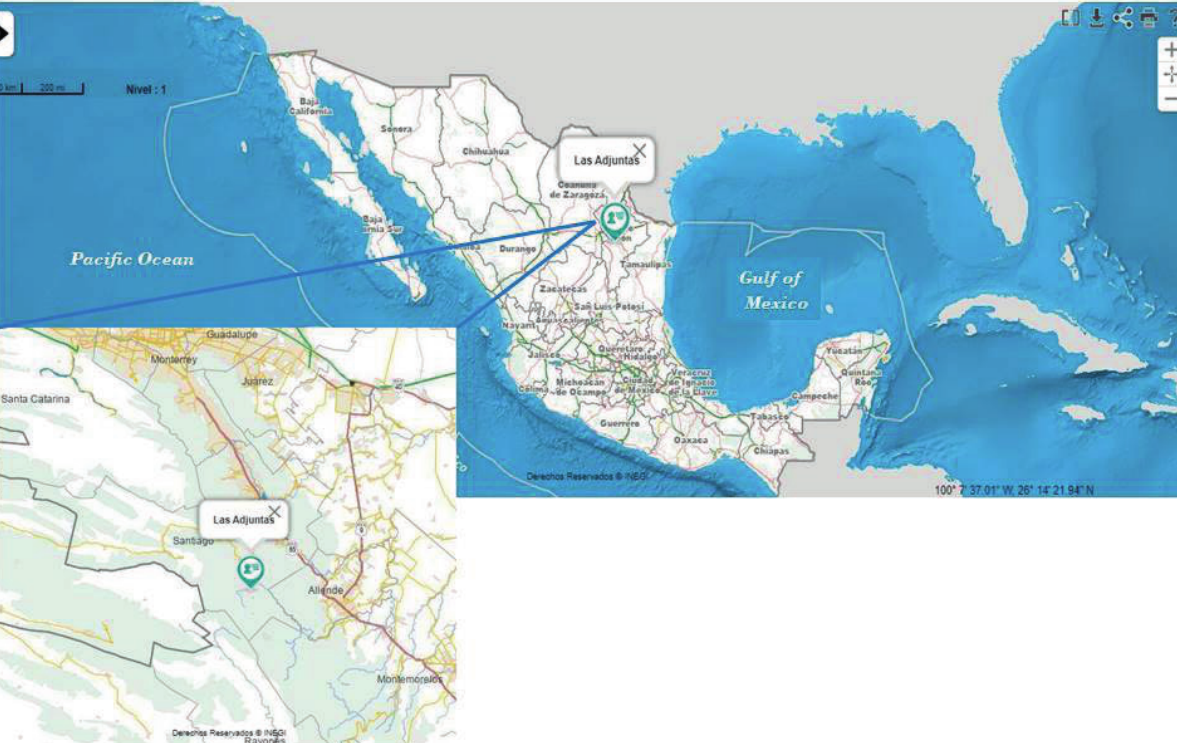
Figure 2. Dasylirion cedrosanum Trel. seed collection site, Las Adjuntas, Santiago, N.L., Mexico (25°18’03.6’’N, 100°08’27.3’’W), as indicated by the red globe (INEGI Map, 2021